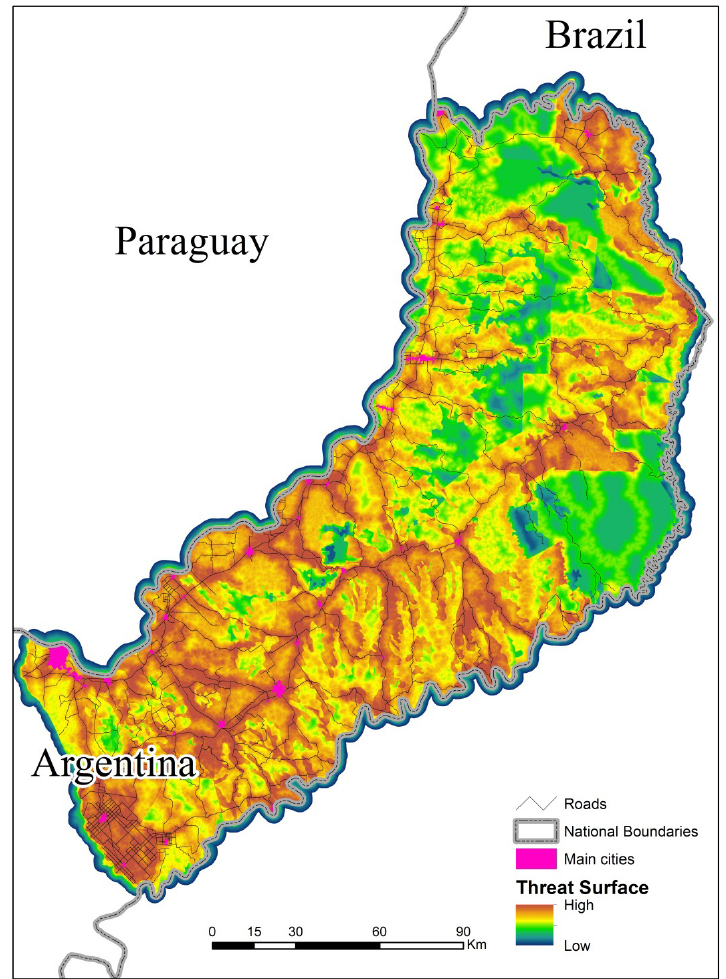
Figure 3. Combined threat